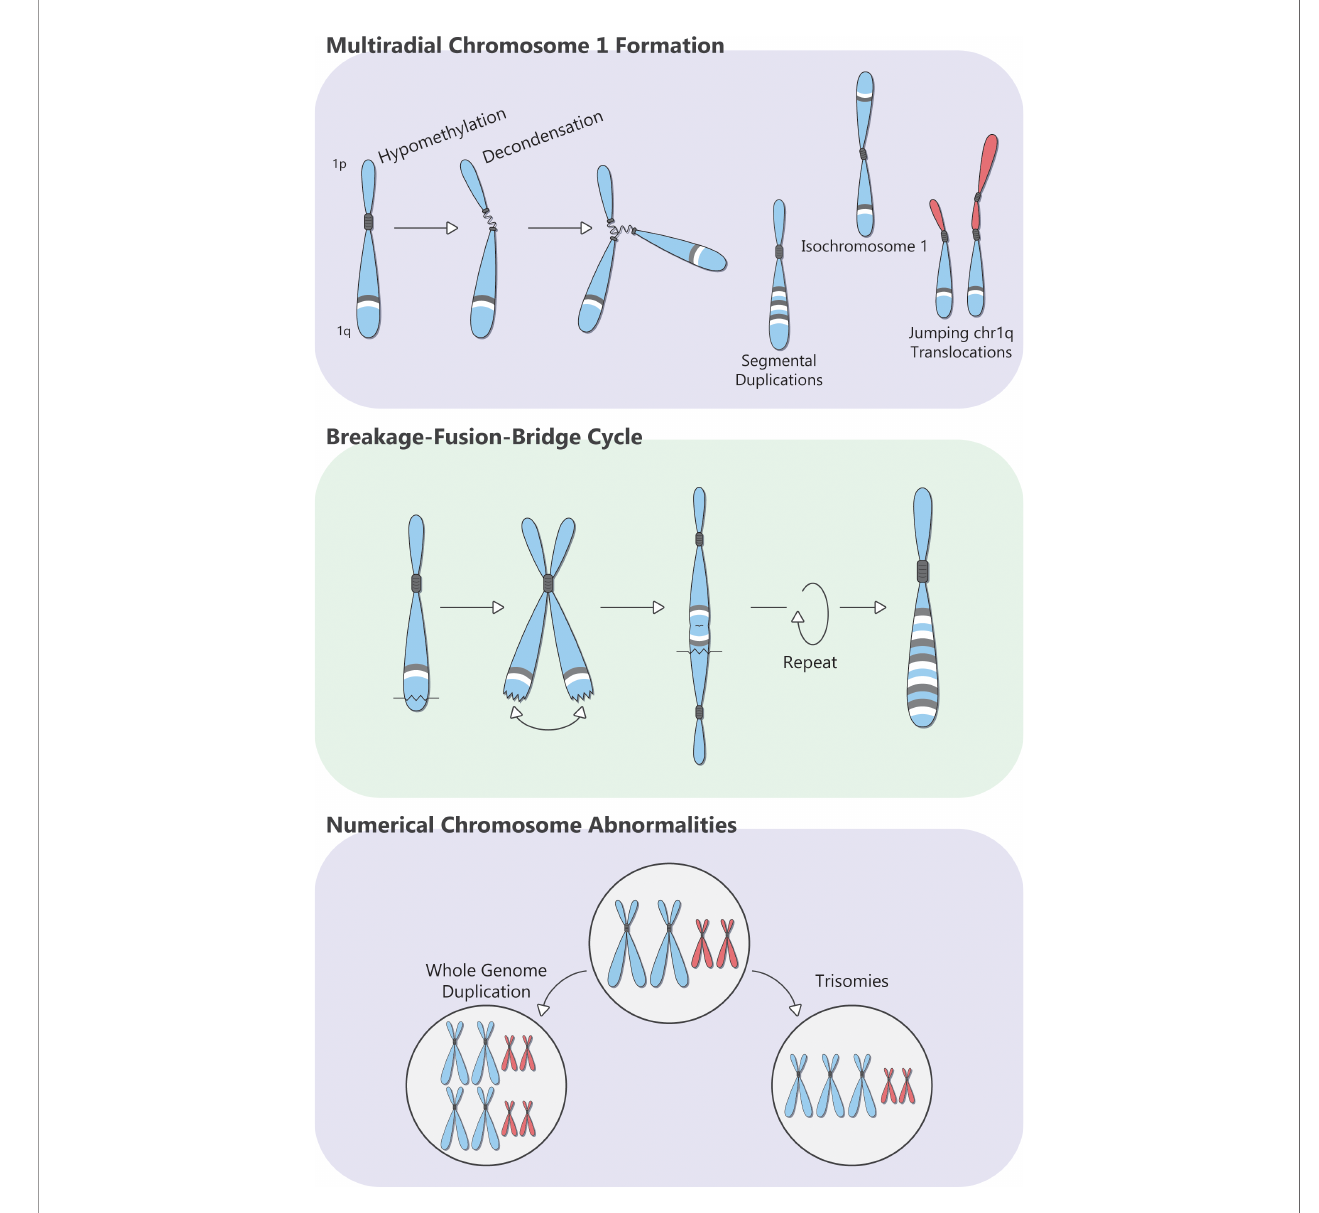
FIGURE 2 | Overview of the pathogenesis of Amp1q in patients with